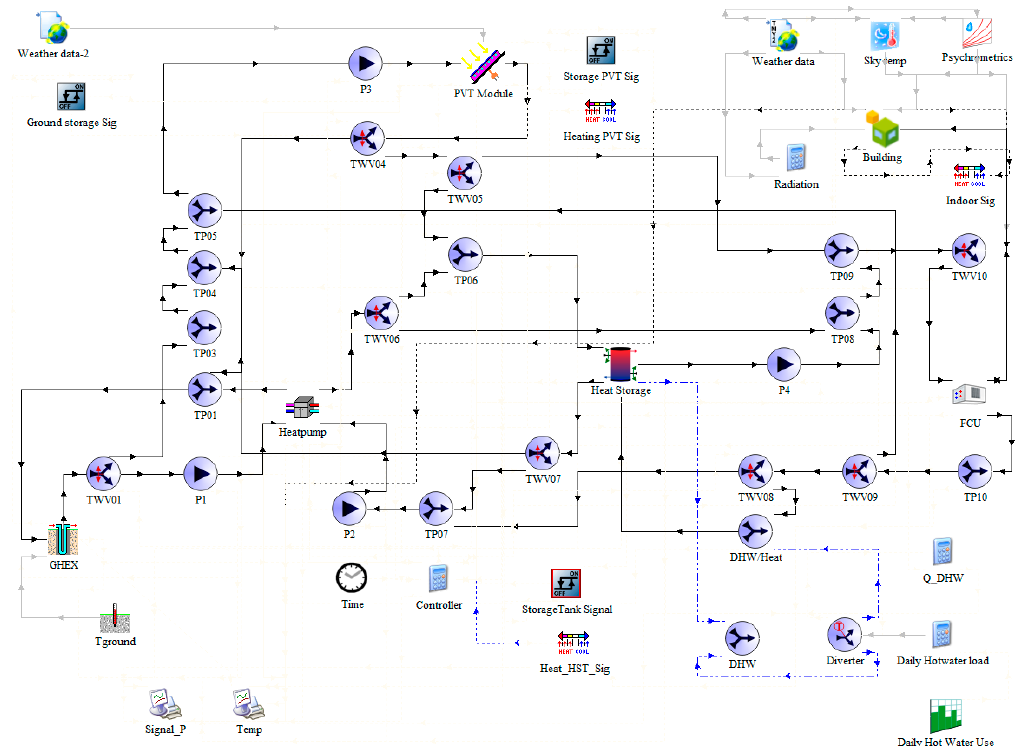
Figure 4. Simulation modelling of Geo-PVT system.